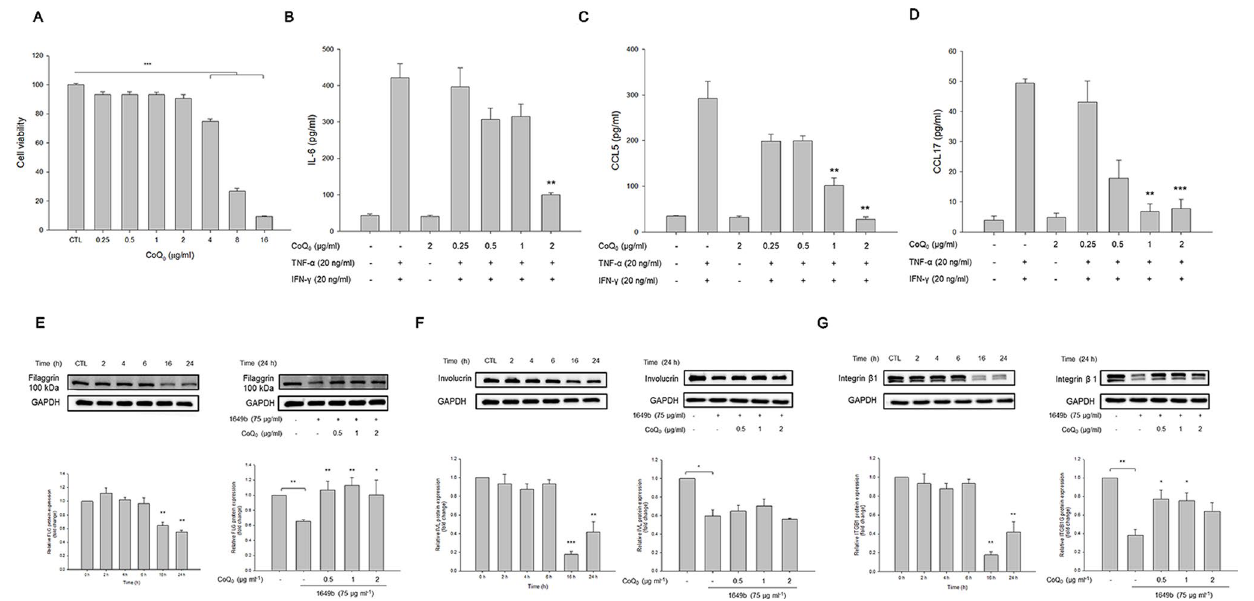
FIgURE 4 | CoQ 0 suppresses TNF-α- and IFN-γ-stimulated cytokines/chemokines and recovers TJ-protein deficiency in HaCaT cells. (A) The cell viability measured by MTT assay. (B) IL-6 in stimulated HaCaT measured by ELISA. (C) CCL5 in stimulated HaCaT measured by ELISA. (D) CCL17 in stimulated HaCaT measured by ELISA. (E) Filaggrin in stimulated HaCaT measured by immunoblotting. (F) Involucrin in stimulated HaCaT measured by immunoblotting. (g) Integrin β1 in stimulated HaCaT measured by immunoblotting. Each value represents the mean ± SEM (n = 4). *** p < 0.001; ** p < 0.01; * p < 0.05.